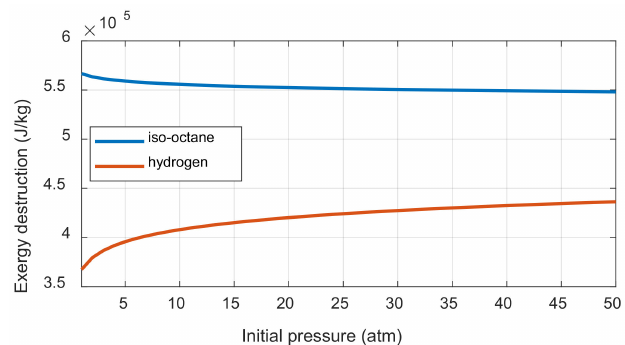
Figure 6. The exergy destruction changes of iso-octane and hydrogen combustion along with the initial